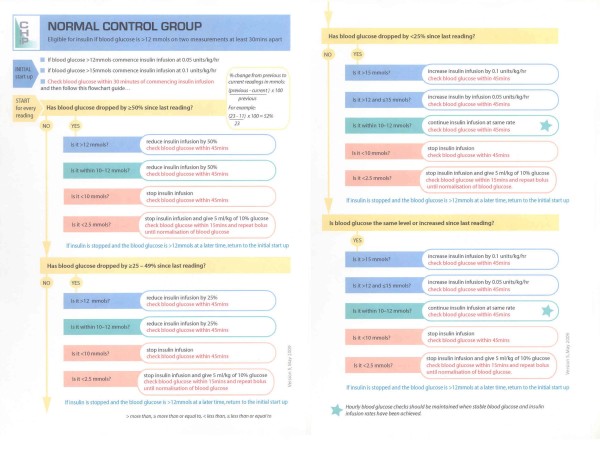
Algorithm for the titration of insulin in the normal control group.